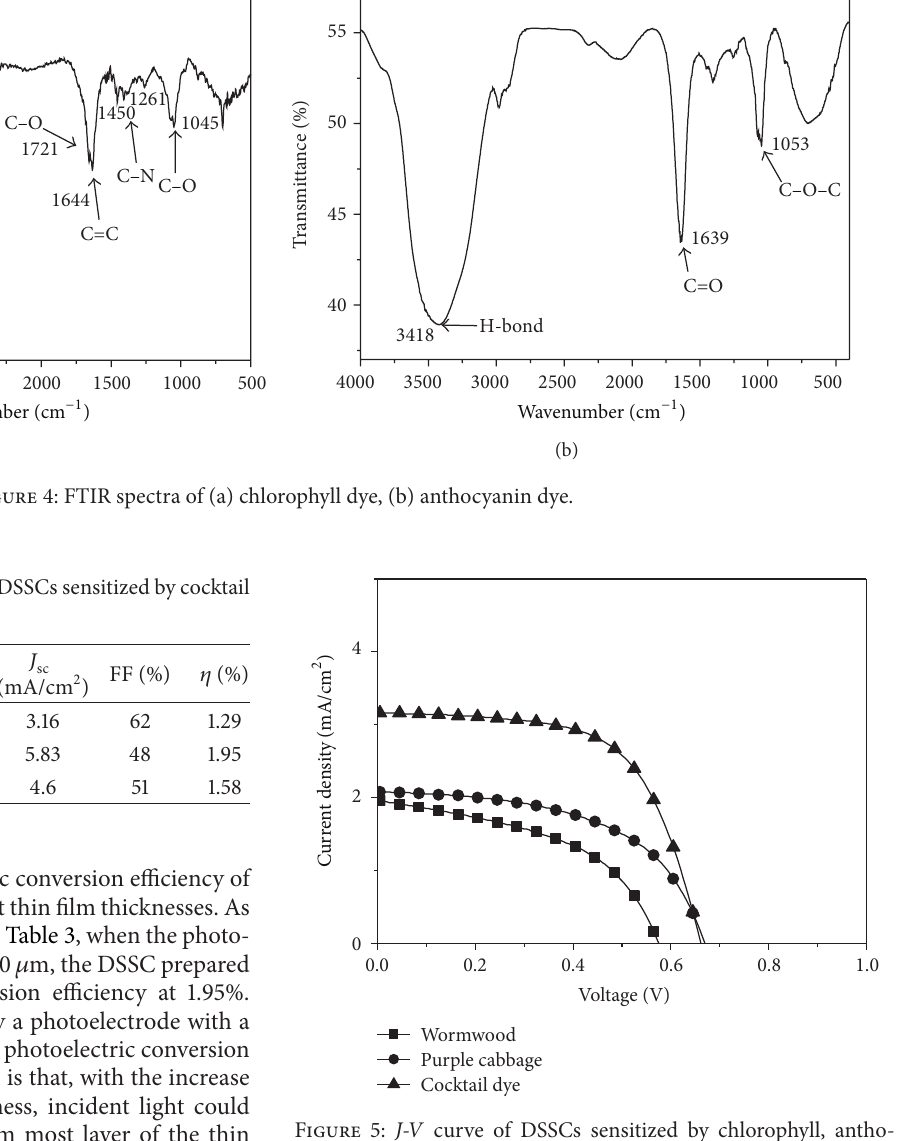
Figure 5: J-V curve of DSSCs sensitized by chlorophyll, antho- cyanin, and cocktail